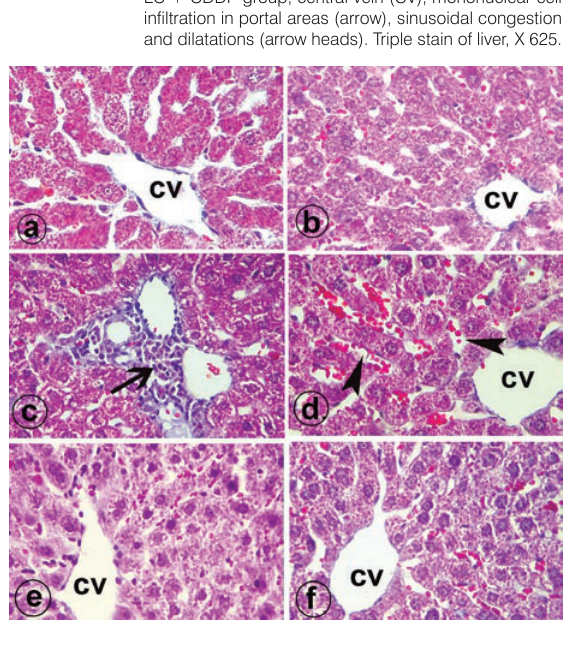
Figure 1. a: Control group, b: LC group, c-d: CDDP group, e-f: LC + CDDP group, central vein (CV), mononuclear cell infiltration in portal areas (arrow), sinusoidal congestion and dilatations (arrow heads). Triple stain of liver, X